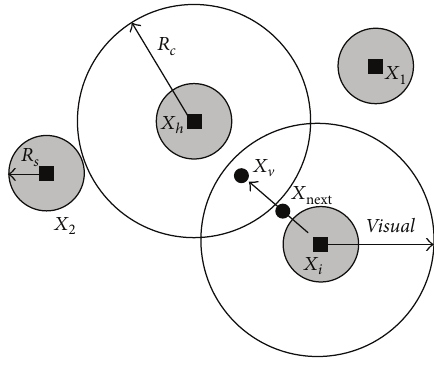
Figure 5: Vision concept of the artificial